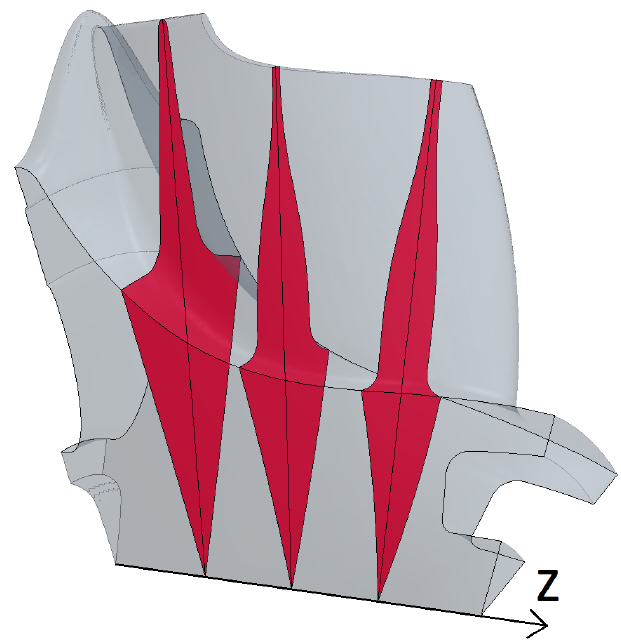
Figure 4. Radially fibered blades.